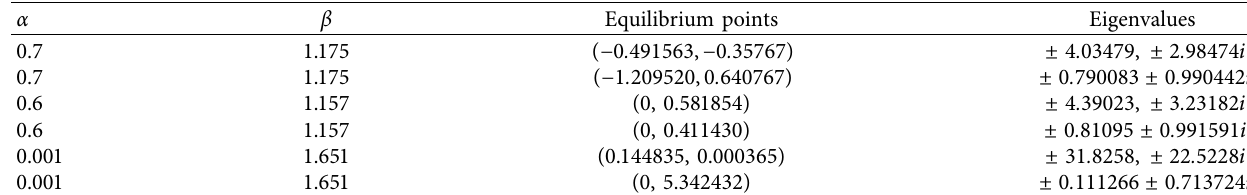
Table 3: Equilibrium points and stability analysis for case II.